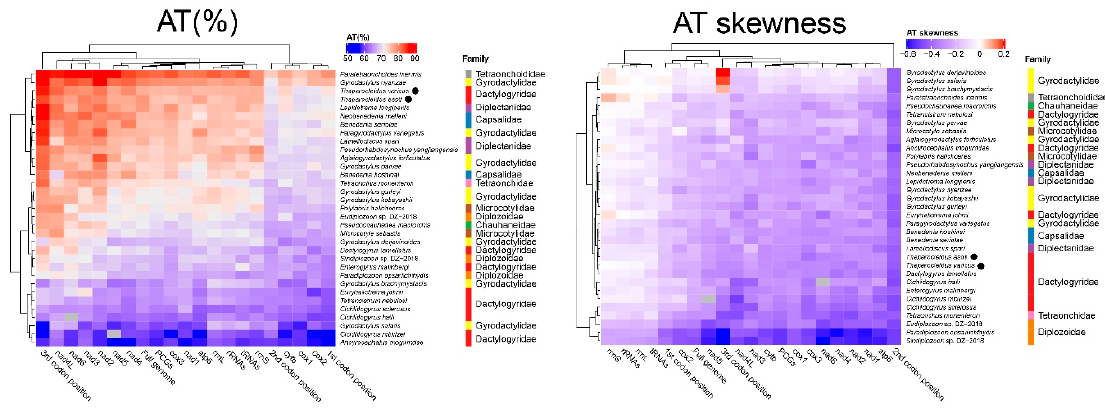
Figure 4. Hierarchical clustering of the A + T content and AT-skewness of various mitogenomic elements among the monogenean mitogenomes.